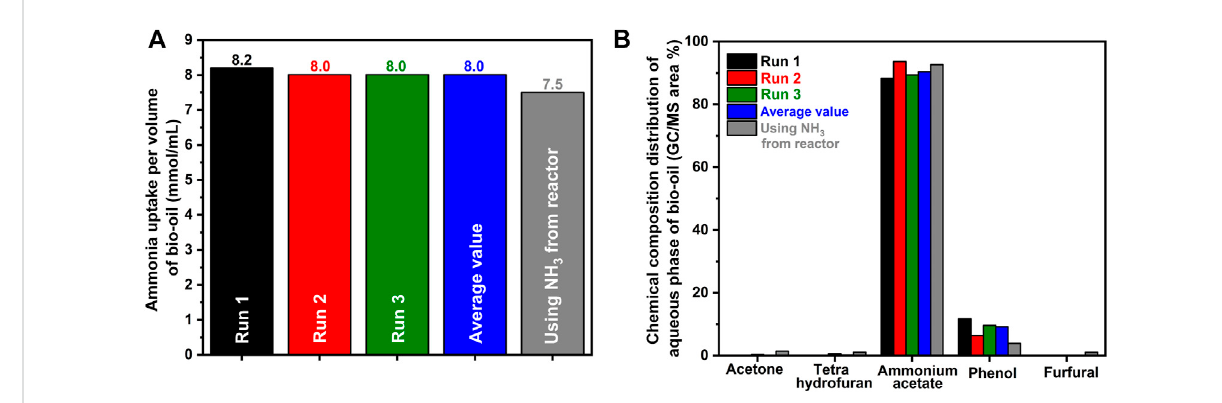
FIGURE 3 (A) Normalized uptake of ammonia by bio-oil and (B) yields and distribution of the separated aqueous phase of bio-oil.